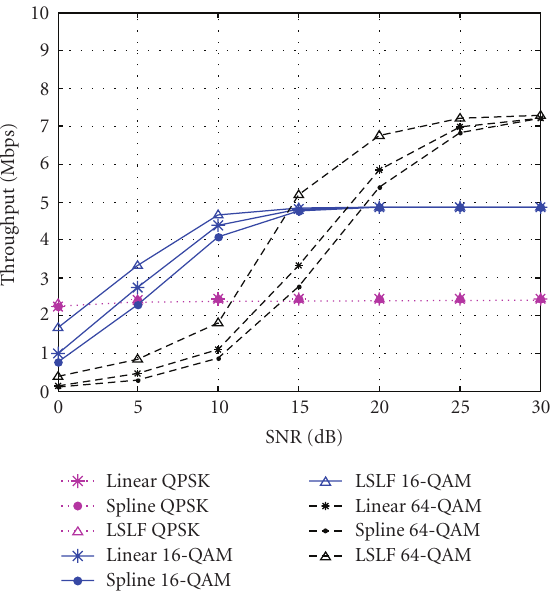
Figure 7: PERs in Veh.A 30km/h.